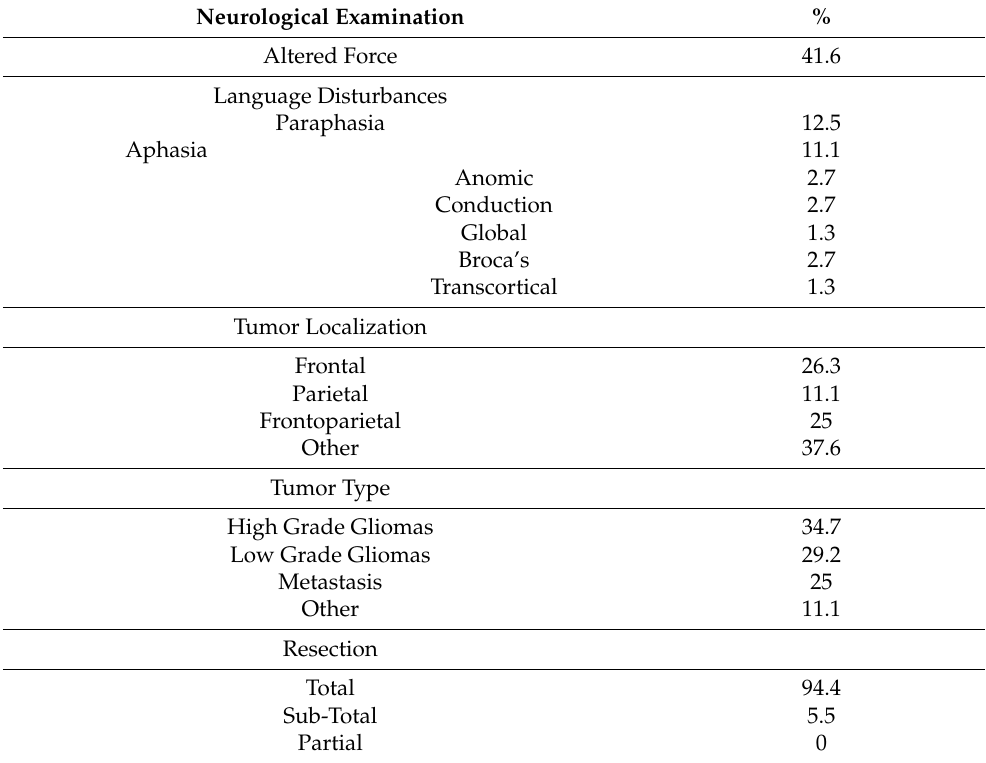
Table 1. Tumor characteristics and related clinical outcome.